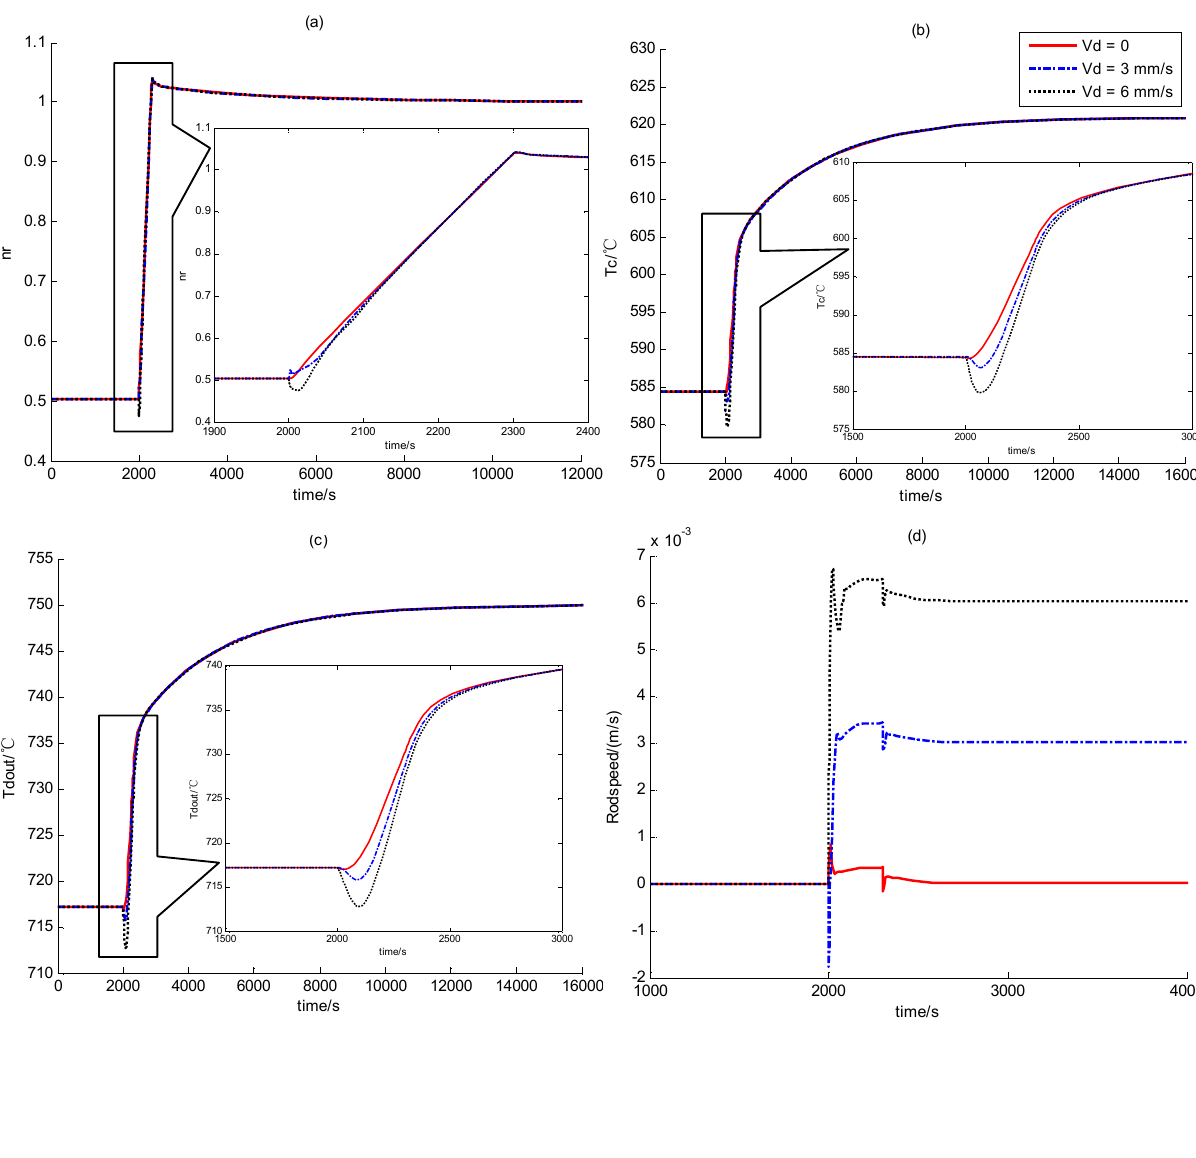
Figure 5. Power lift controlled by feedback dissipation PLC. ( a ) Relative nuclear power-level; ( b ) Average temperature of fuel elements; ( c ) Outlet helium temperature of the reactor; ( d ) Control rod speed